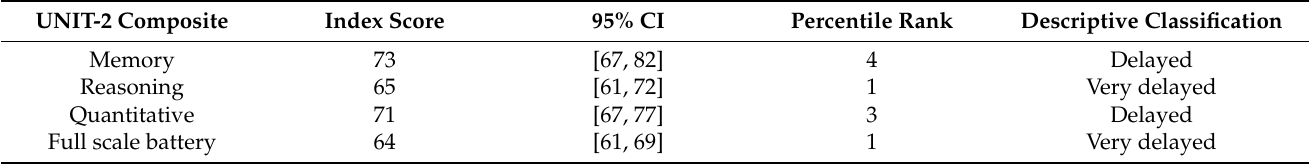
Table 2. Results of Intellectual Functioning using